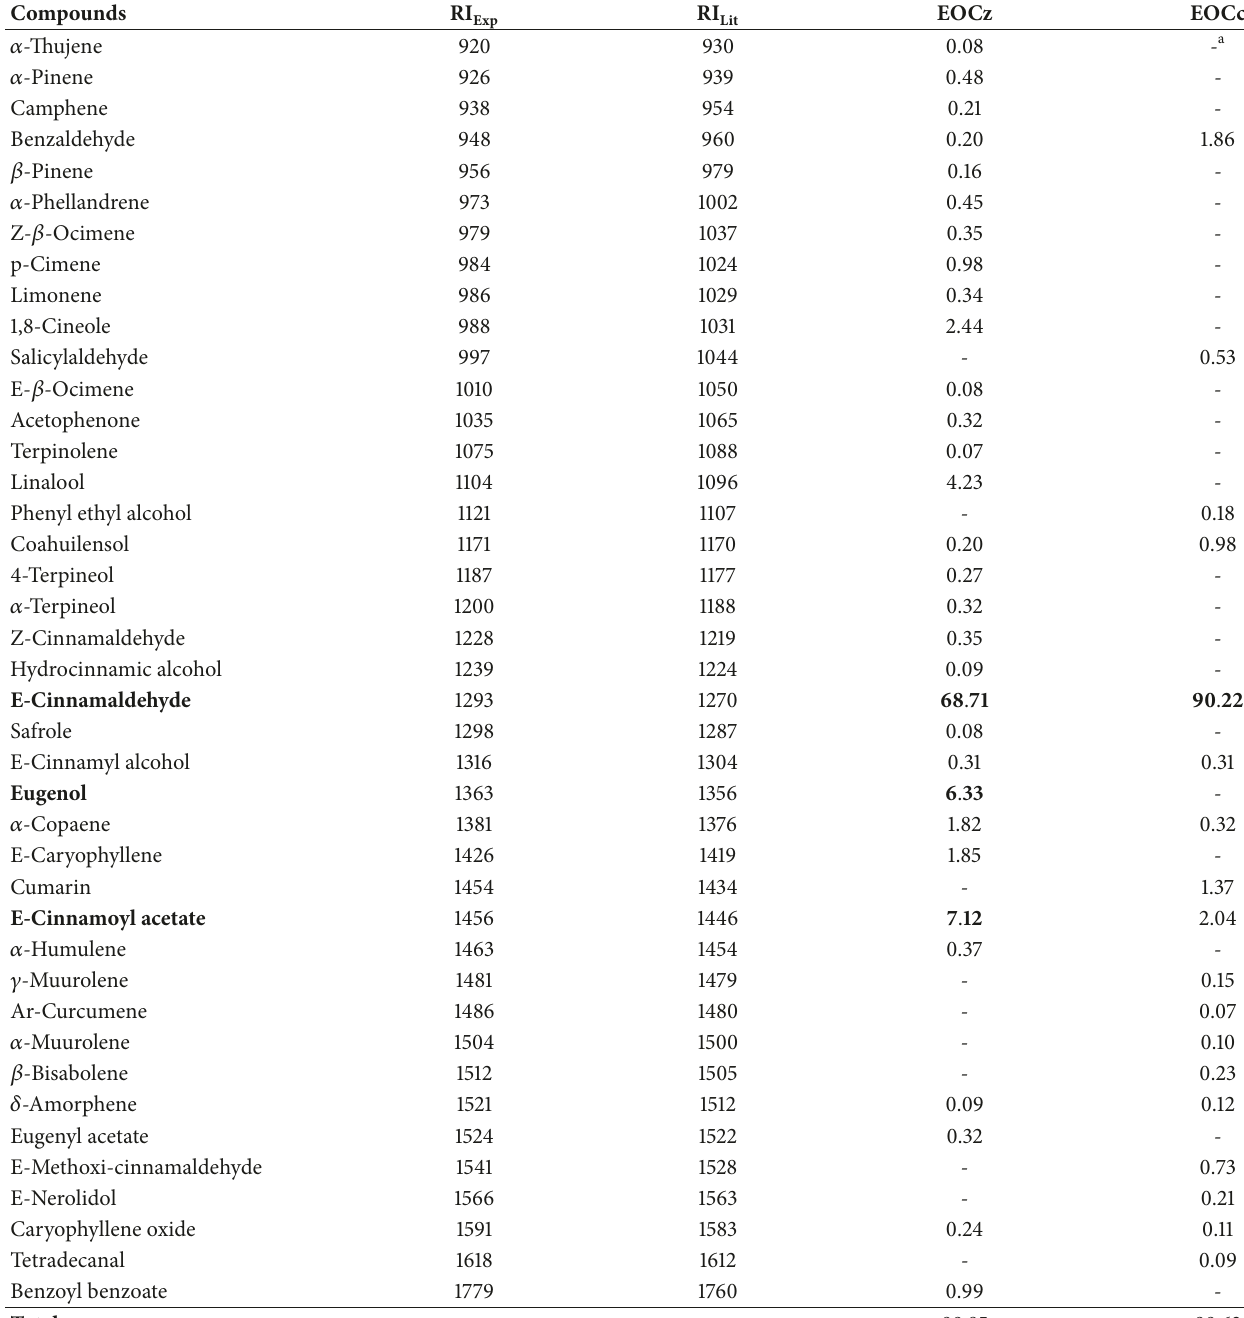
Table 1: Chemical composition, retention index experimental (RIExp), retention index of the literature (RILit), and percentage of the identified components (%) from the essential oils of C. zeylanicum (EOCz) and C. cassia (EOCc)